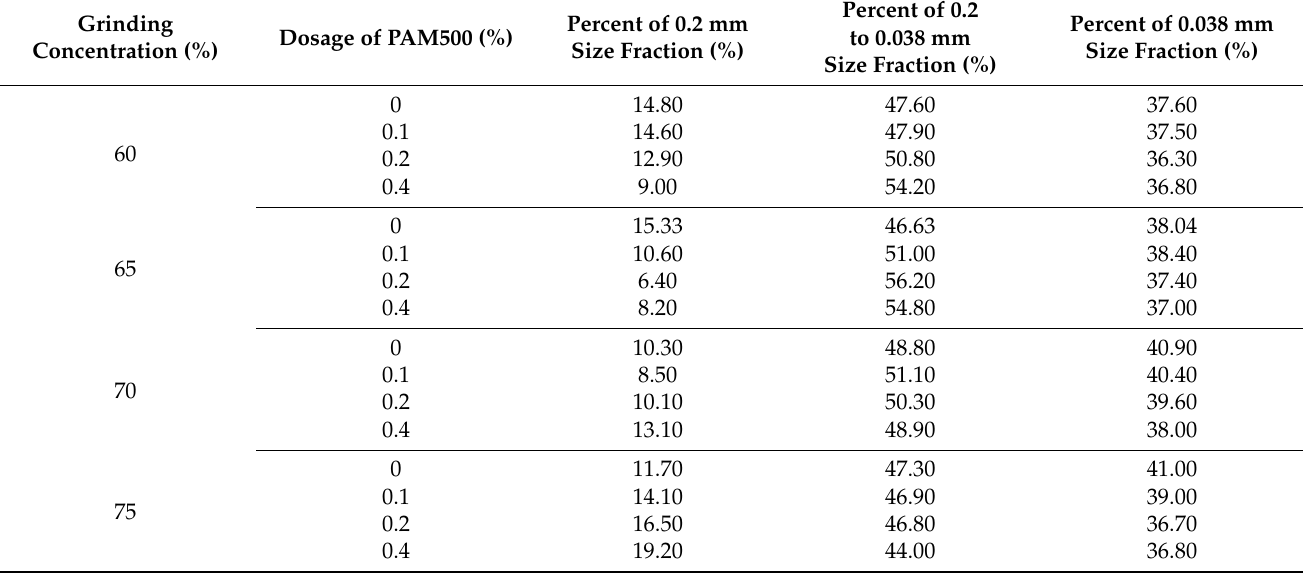
Table 2. The relationship between the dosage of PAM500 and the percentages of the product size fractions using different grinding